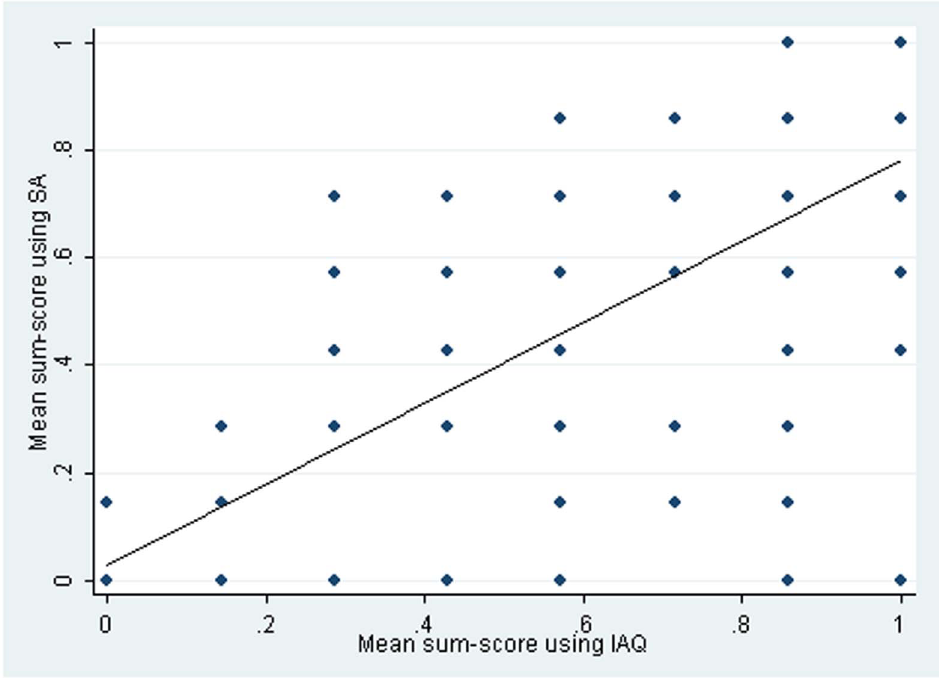
Figure 2. Association between essential items score for those completing two rounds using different modes each round (n=131).